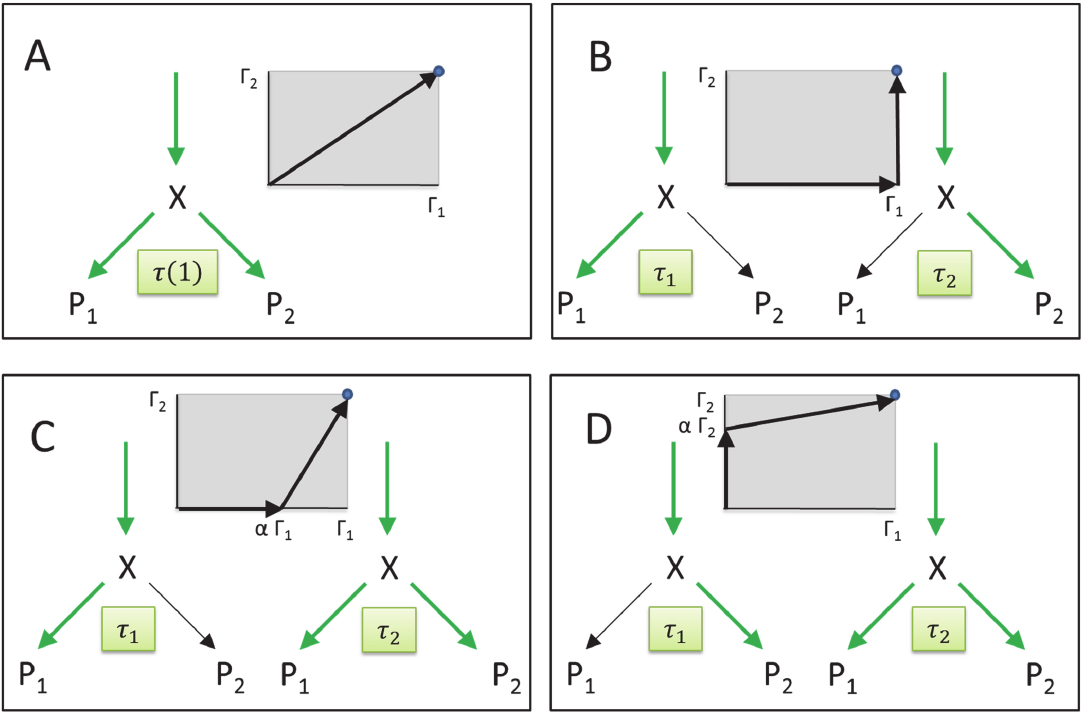
Fig 1. Simplistic metabolic network with two target fluxes. Strategy A: All genes are constantly active, the demanded metabolic output is generated during the time interval τ 0 by a single flux mode composed of the two MinModes w 1 and w 2 (= reference case). Strategy B: The two minimal gene sets are separately active, during the first time interval τ 1 only the demanded amount of product P 1 is generated, whereas in the second time interval τ 2 only the demanded amount of P 2 is produced. Strategy C: During the initial time interval τ 1 only the minimal gene set χ 1 is active and only a certain fraction α < 1 of the demand for P 1 is produced. Thereafter, the second minimal gene set is additionally activated so that the products P 1 and P 2 are produced simultaneously. Strategy D: During the initial time interval τ 1 only the minimal gene set χ 2 is active, thereafter the second minimal gene set is additionally activated so that the products P 1 and P 2 are produced simultaneously. The gray-shaded panels illustrate the proportions in which the demanded amounts Γ 1 and Γ 2 of the two output metabolites are produced in strategies A-D.